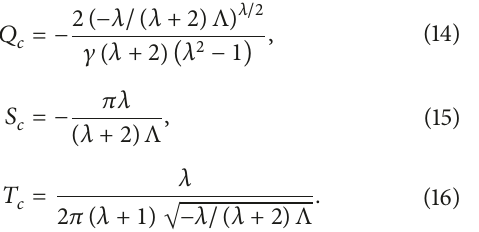
Figure 7: The figure shows 𝐹 versus 𝑇 for 𝛾 = −1 . Here 𝜆 = 2.4 , Λ = −3 , and 𝑄 = 0.6𝑄 𝑐